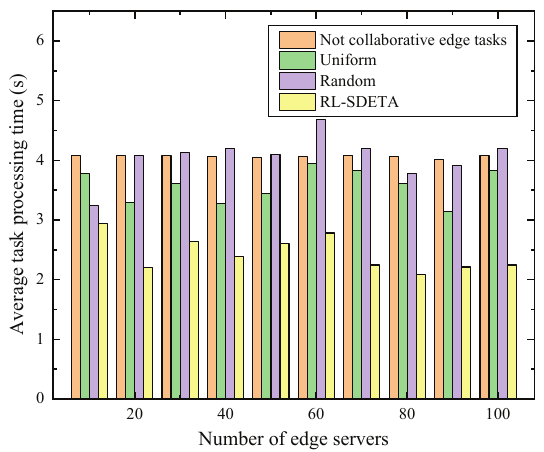
Figure 8. Effect of average task processing